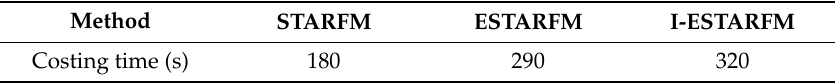
Table 6. Average computing time of three